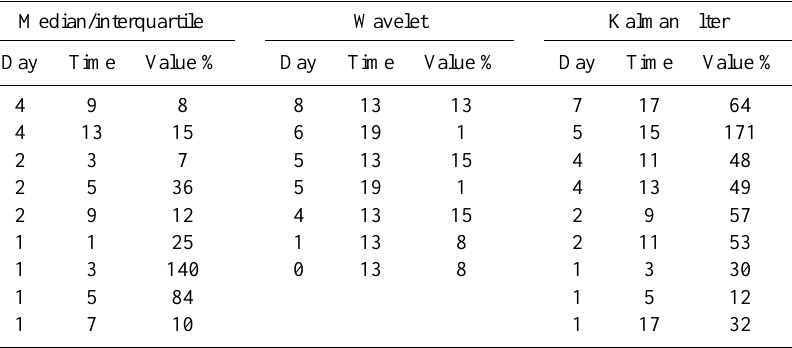
Table 3. Detected anomalies for the Samoa earthquake (29 September 2009) using the median/interquartile, wavelet and Kalman filter methods (Akhoondzadeh and Saradjian,